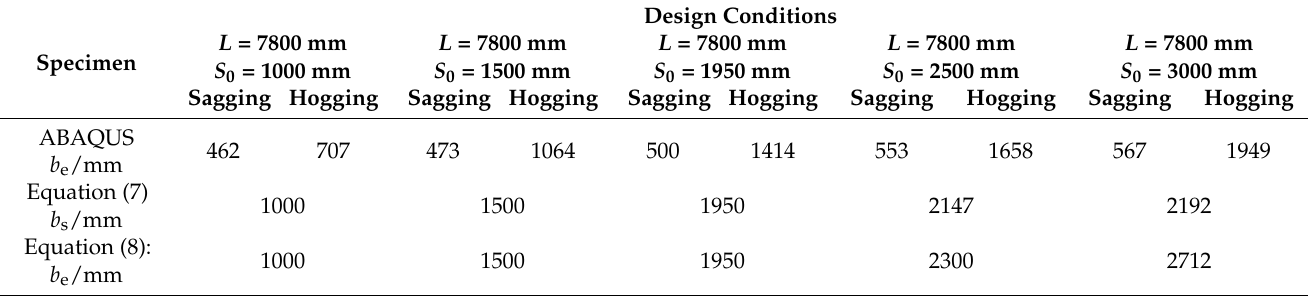
Table 5. The effective slab width under changing S 0